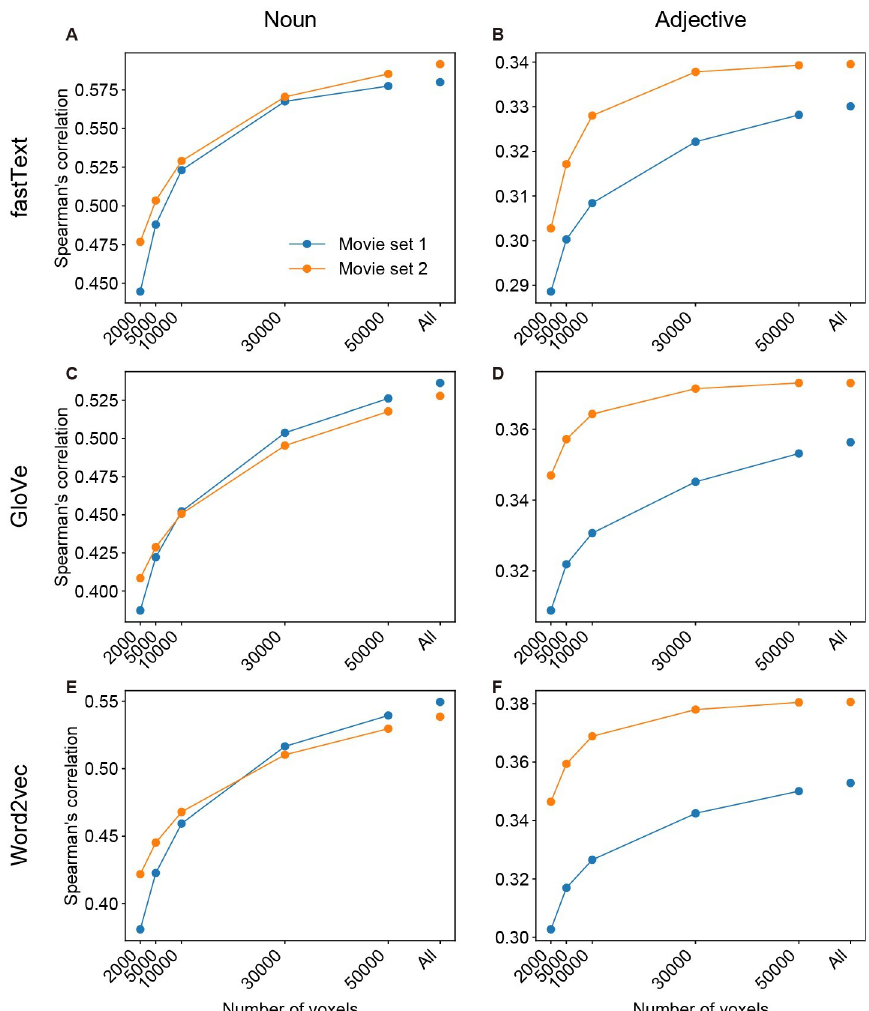
Fig 8. Effects of voxel selection on brain–behavior correlation. We have evaluated the correlations between brain- and behavior-derived word dissimilarity matrices when the brain-derived matrix was obtained from the selected voxels with the highest model accuracy. The correlation coefficients for fastText ( A and B ), GloVe ( C and D ), and word2vec ( E and F ) vectors are shown separately for nouns ( A , C , and E ) and adjectives ( B , D , and F ), while the numbers of selected voxels are changed (2000, 5000, 10000, 30000, 50000, and all